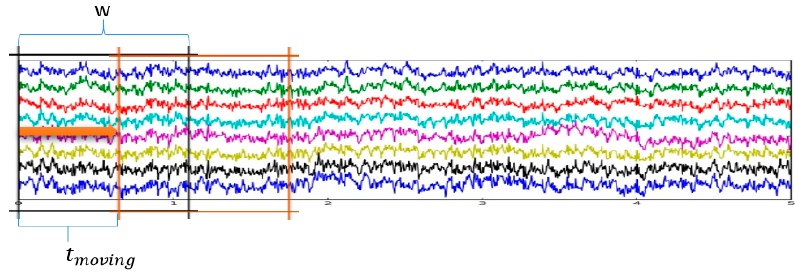
Figure 5. Graphical illustration of the augmentation process.